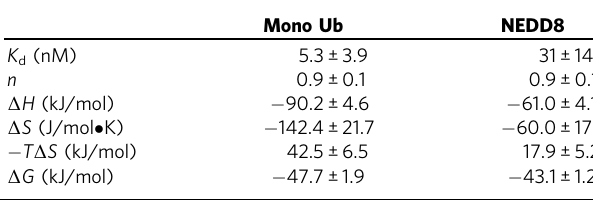
Table 1 Thermodynamic parameters for OtDUB UBD binding Ub and NEDD8 as determined by